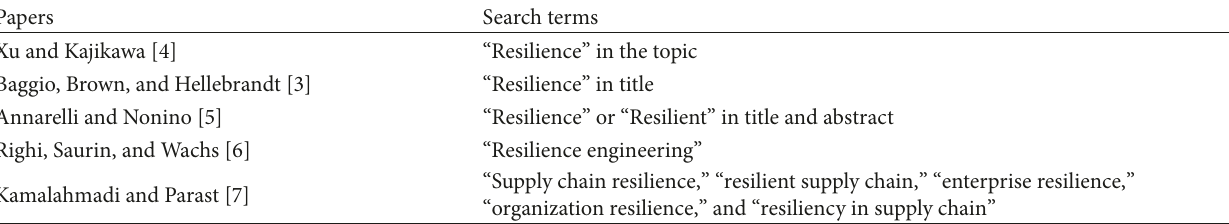
Table 1: Search terms used in previous literature review